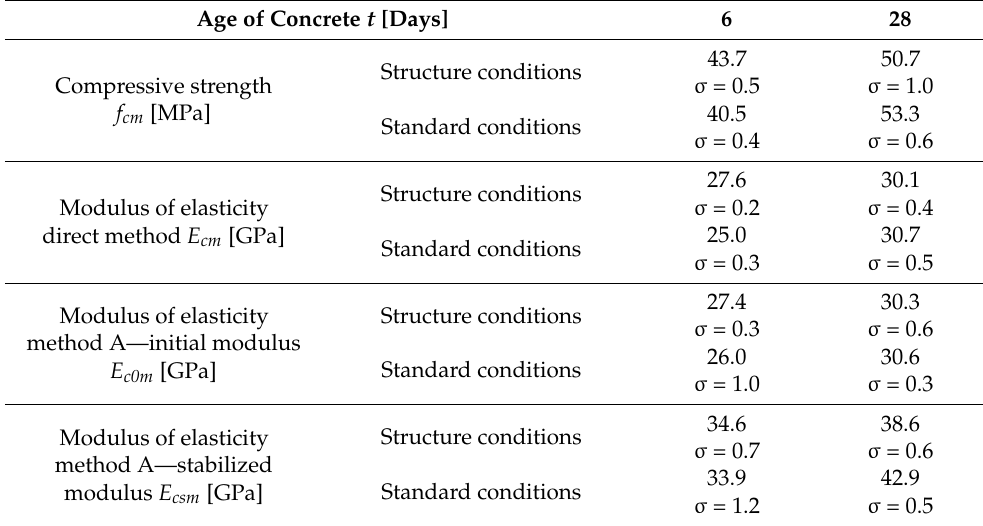
Table 4. Summary of laboratory test results–WG-4